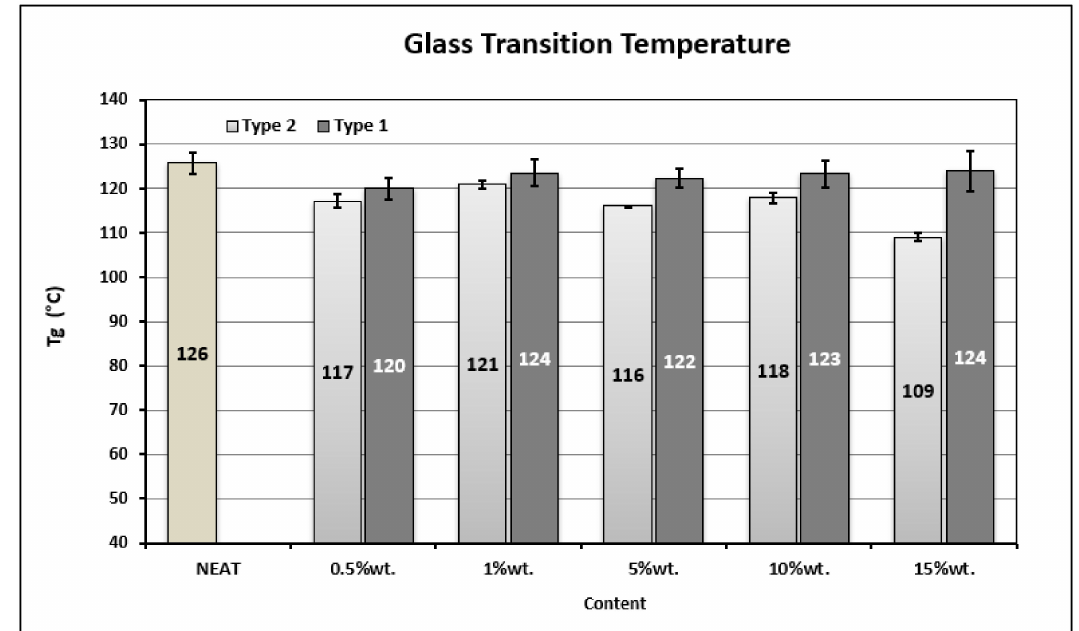
Figure 3. Thermo-mechanical properties of the produced